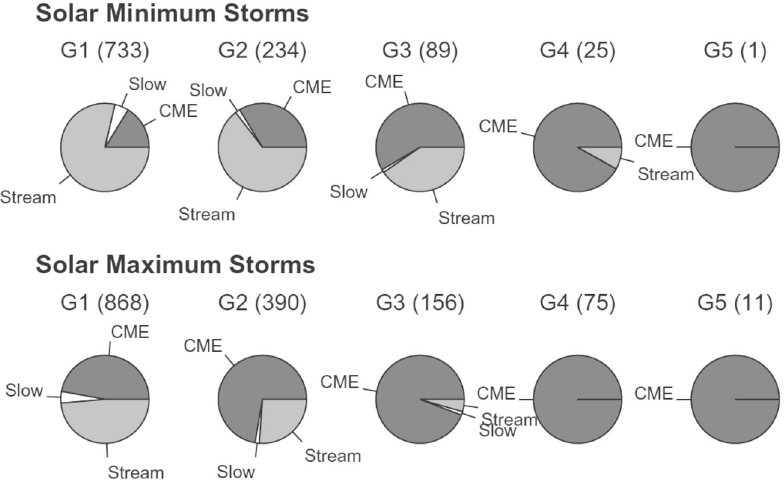
Fig. 32 Drivers of geomagnetic storms around solar minimum and solar maximum accumulated over four solar cycles (1964–2011). The geomagnetic storm definition follows NOAA storm scale (http://www.swpc. noaa.gov/noaa-scales-explanation). Image reproduced by permission from Richardson and Cane (2012b), copyright by the